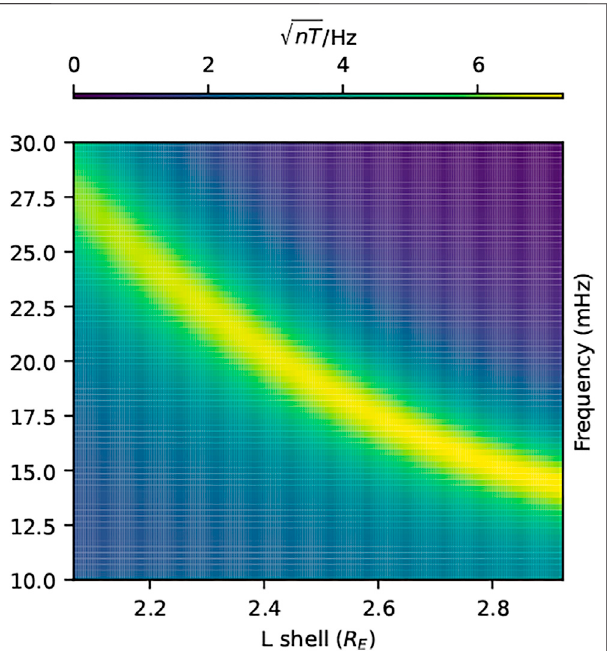
FIGURE 9 | Amplitudes calculated from Eq. 7 mapped between 2.07 and 2.92 R E using the FLR with L pro fi le for 19 June 2015.